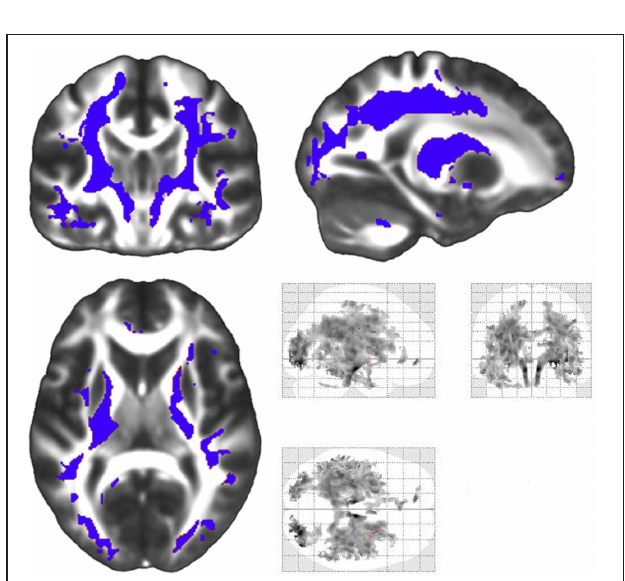
FIGURE A1 | A supplementary whole-brain analysis of radial diffusivity change among patients that was not restricted to regions demonstrating an FA effect was conducted. This analysis was carried out in the same radial diffusivity factorial model used in the restricted radial diffusivity analyses, and statistical thresholds used in FA analyses were employed. This analysis examined decreases in radial diffusivity during the four year study duration. Regions of decreased radial diffusivity included significant longitudinal decreases in radial diffusivity in superior and inferior longitudinal fasiculi, internal and external capsules, forceps major and minor and the descending corticospinal tract (blue). The tubular regions of change that extend through the descending corticospinal tract were not constrained on any side by the white matter mask employed in our analyses. The left side of the statistical map is patient left and right is patient